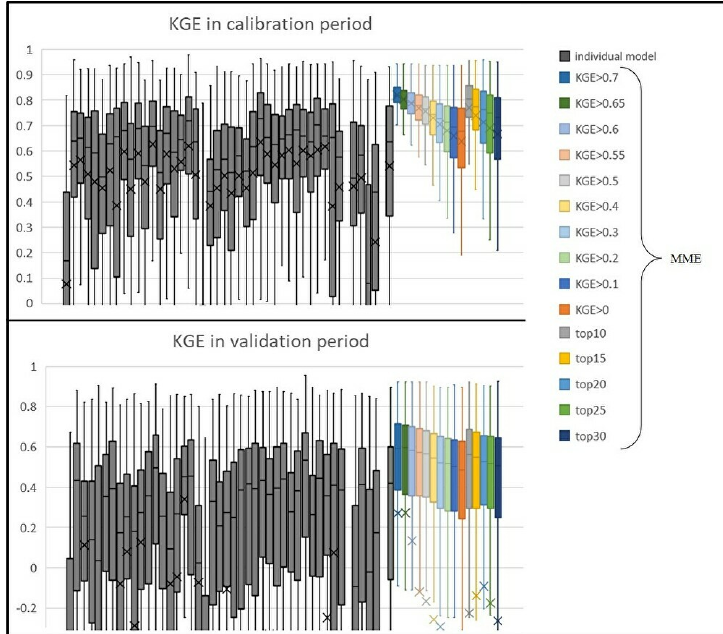
Figure 3. Box plots of KGEs predicted by each model alone (gray box) and by MME (colored box) for all 582 basins for which KGEs could be calculated. KGEs for the calibration period are shown in the top panel, and KGEs for the validation period are shown in the bottom panel. For MME, the 10 series on the left are MME which selected models by the threshold of KGE during the calibration period, and the 5 series on the right are MME which selected models by the rank of KGE during the calibration period.